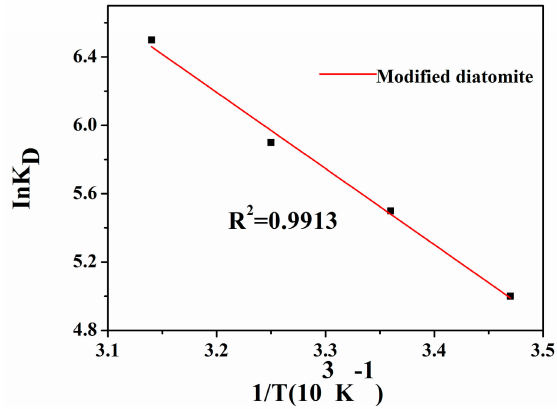
Figure 15. Calcined 450 ◦ C diatomite adsorption of 1-naphthol lnK D versus 1/T (pH 3, 1-naphthol concentration 10 mg/L, diatomite consumption 0.5 g and adsorption time 30